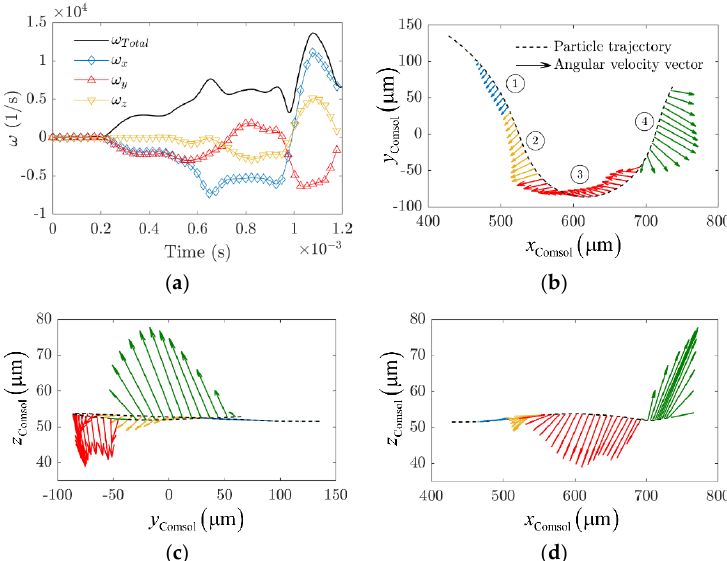
Figure 10. ( a ) Angular velocity components of the particle as a function of the simulation time. ω Total is the total angular velocity magnitude; ( b ) Angular velocity vector along the trajectory of the particle as seen from a zenithal view; ( c , d ) Angular velocity vector seen from different perspectives in COMSOL’s frame of reference.